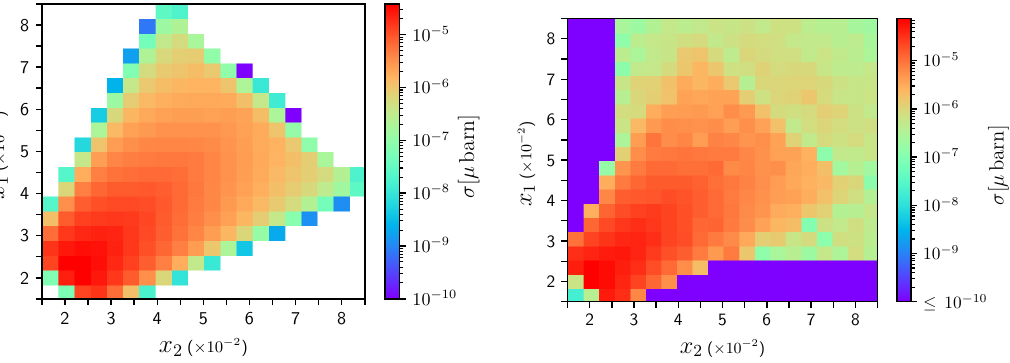
Figure 11: Correlation between x QED (right) accuracy. Even when including NLO real corrections, there is a strong suppression for those events with rather different values of x the events using RHIC kinematics with